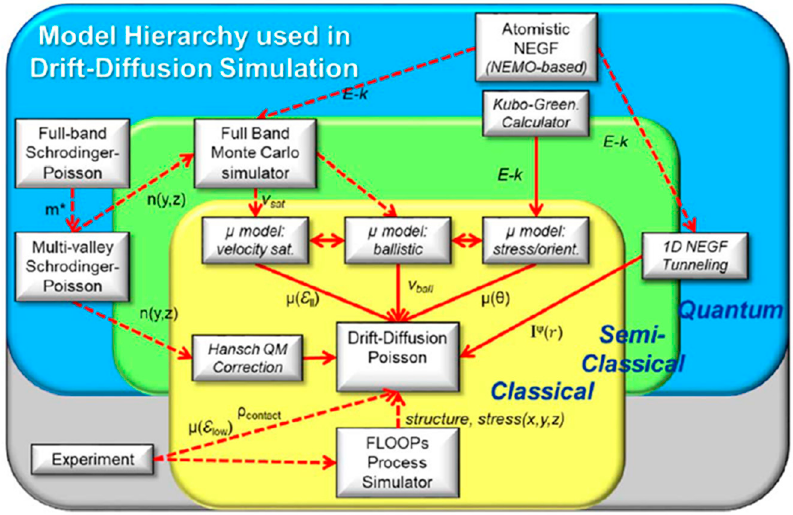
Figure 14. Ilustration of the advanced drift-diffusion (DD) calibration and applications [73].